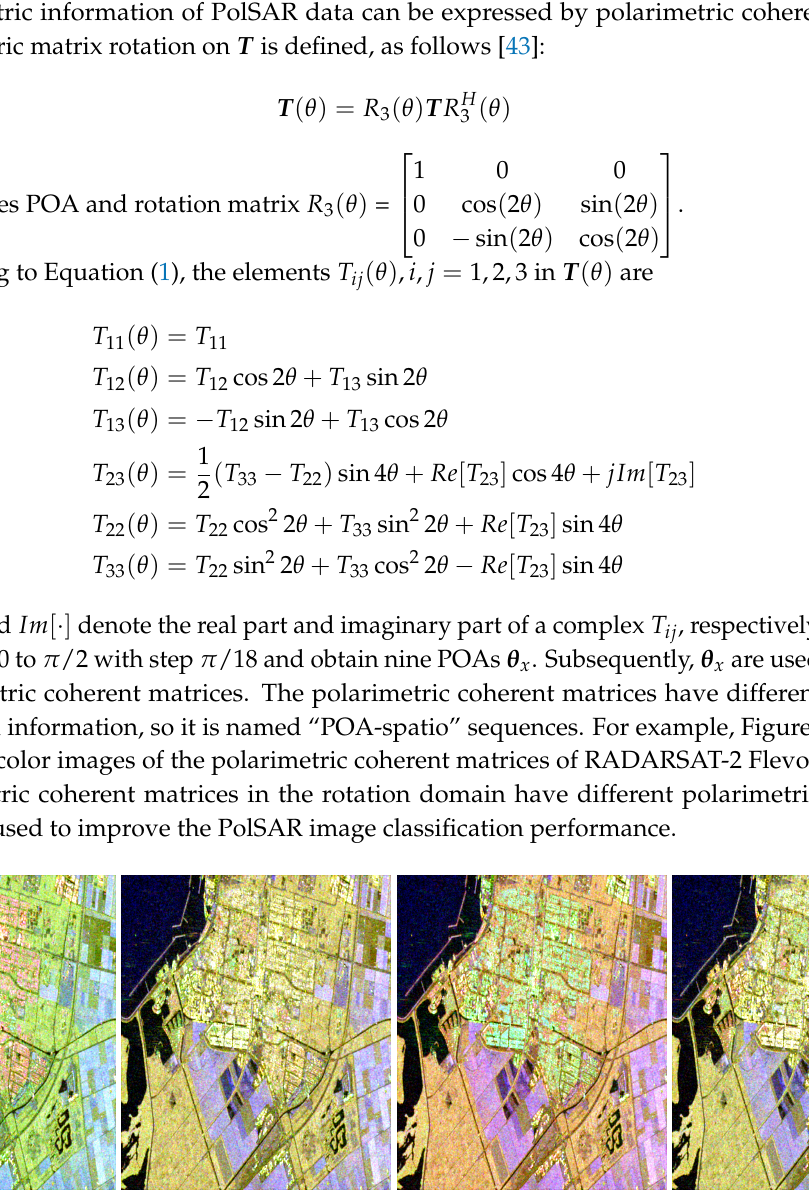
Figure 2. Pauli pseudo-color images of polarimetric coherent matrices of RADARSAT-2 Flevoland. ( a ) POA = π ; ( b ) POA = 3 π ; ( c ) POA = 5 π ; ( d ) POA = 7 π 18 18 18 18